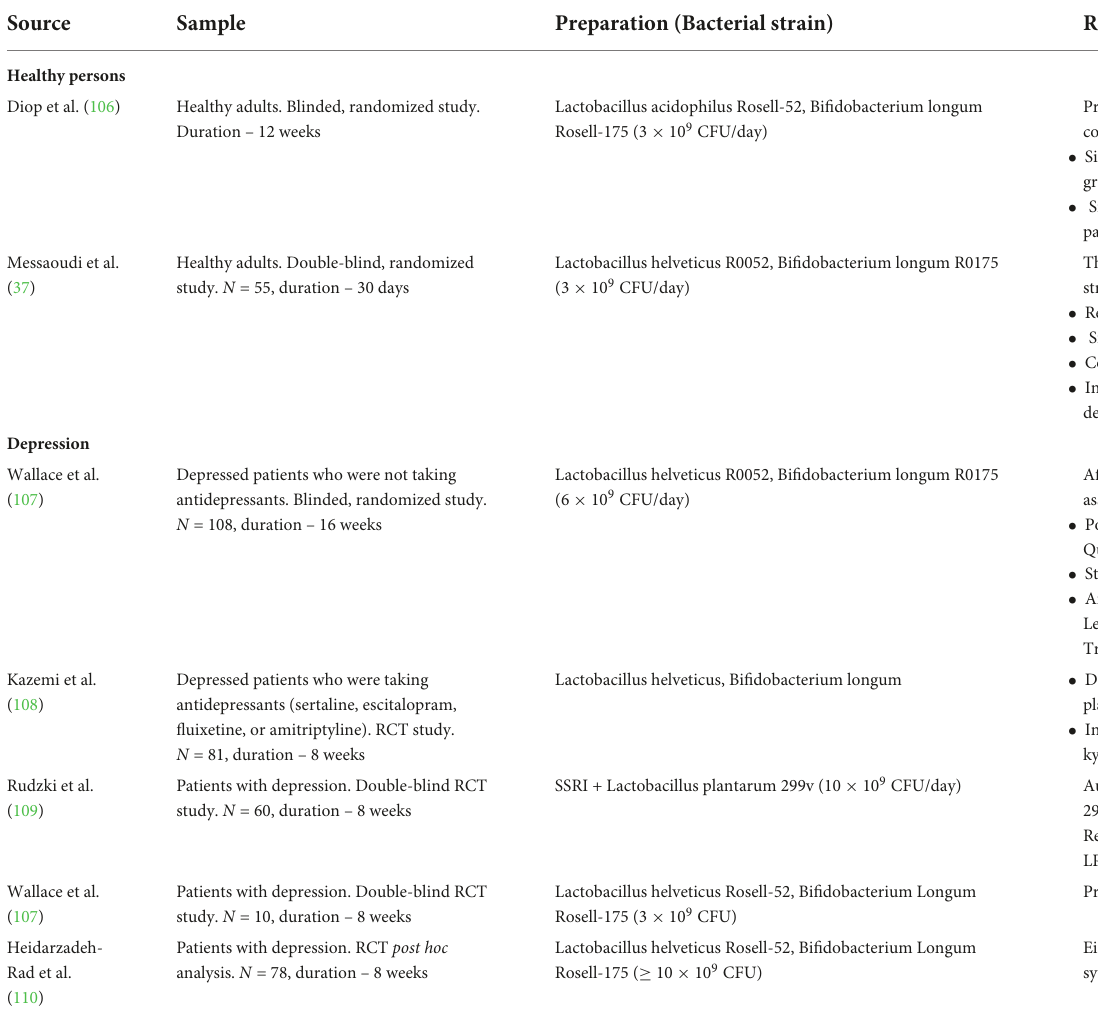
TABLE 2 Review of selected studies on the psychoprotective effects of substances contained in food.